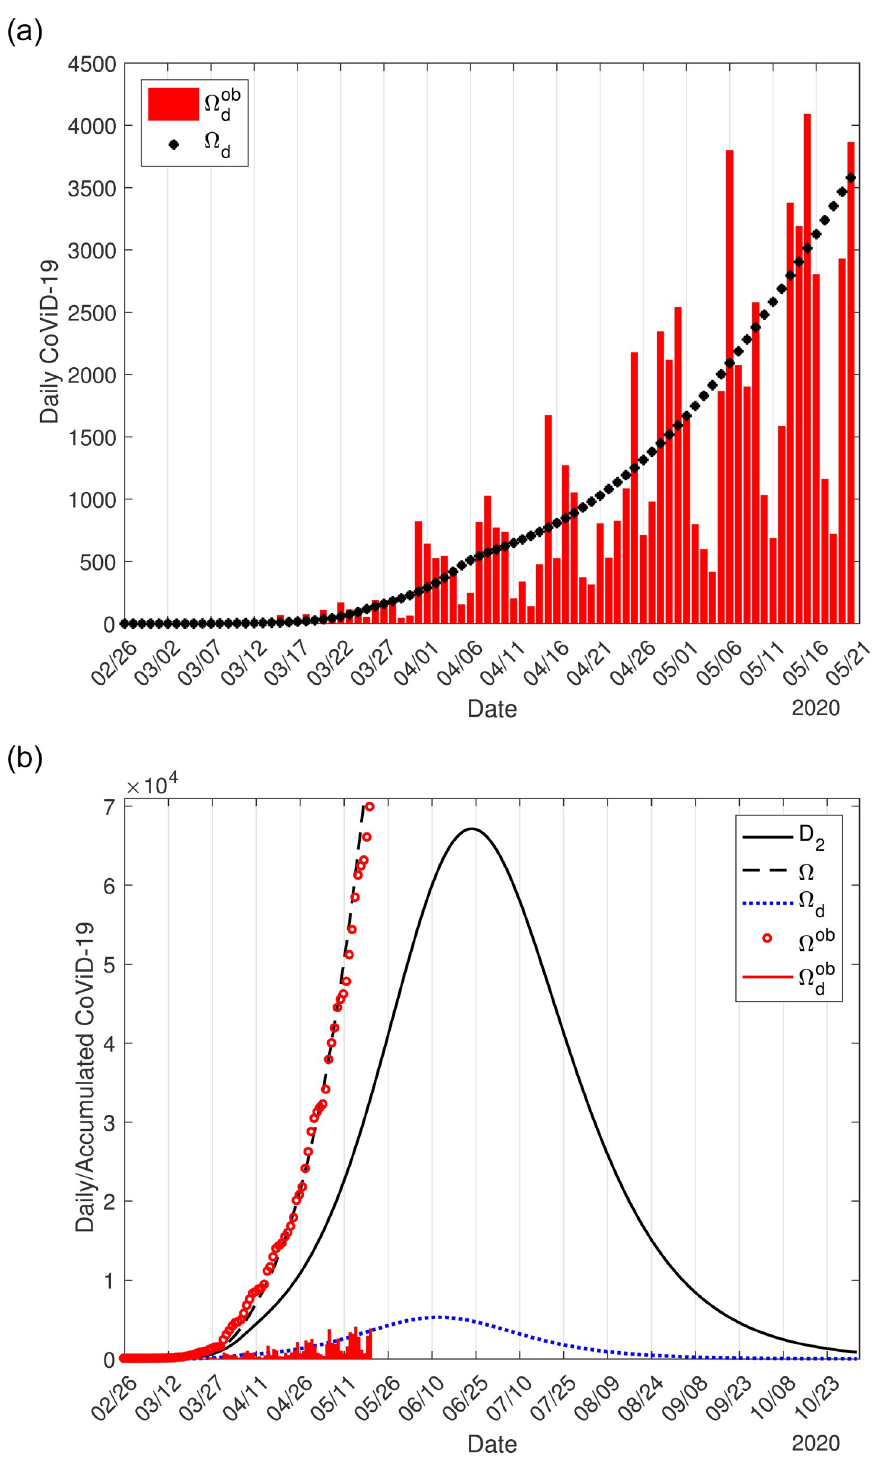
Fig 4. The calculated curve O d and observed daily cases in S ã o Paulo State (a), and the initial part of the estimated curve O with observed data O ob , the extended O